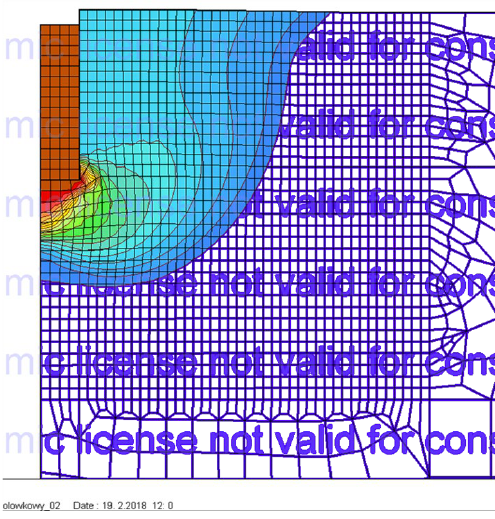
Figure 6: Failure mode of the single